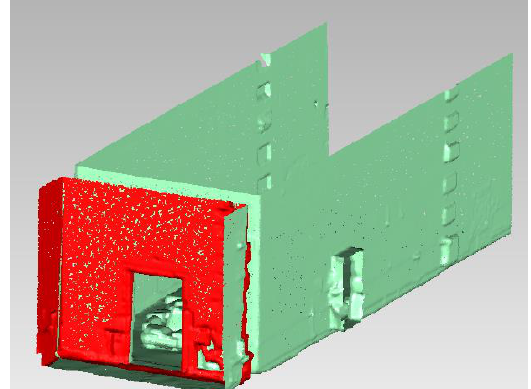
Figure 5. Displaying planes in red to apply the edge detection process.